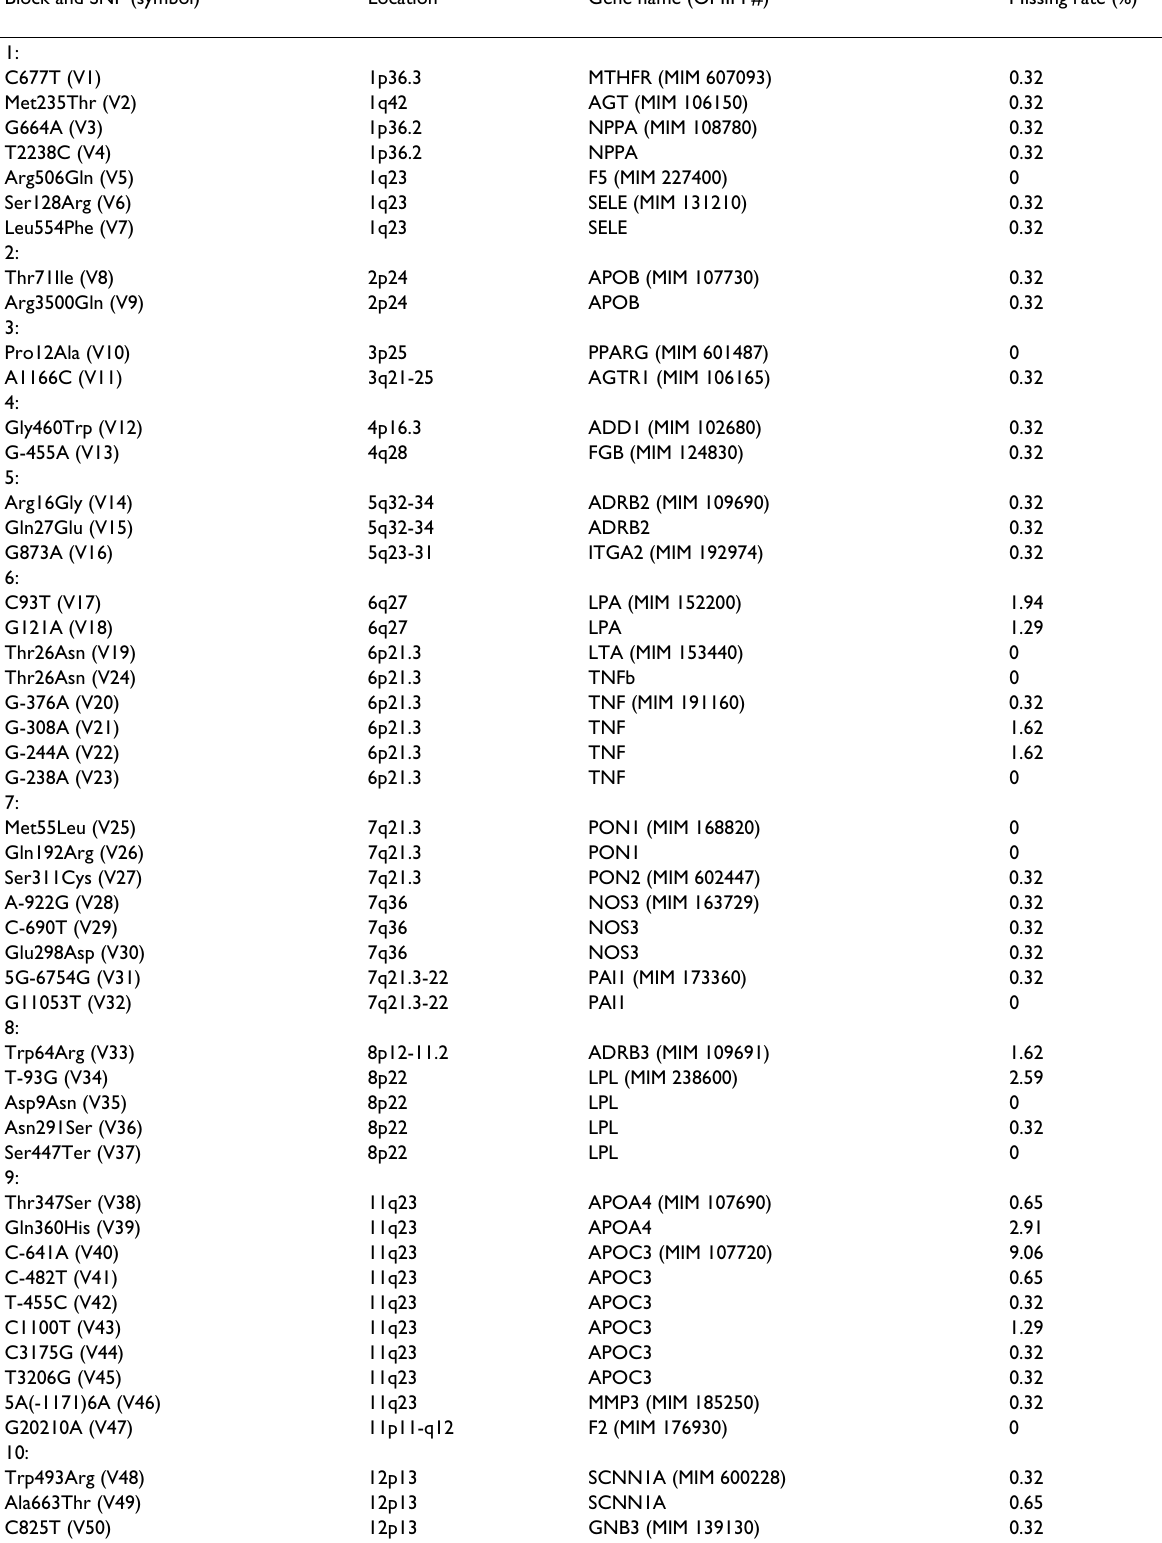
Table 2: Polymorphisms used in genotyping